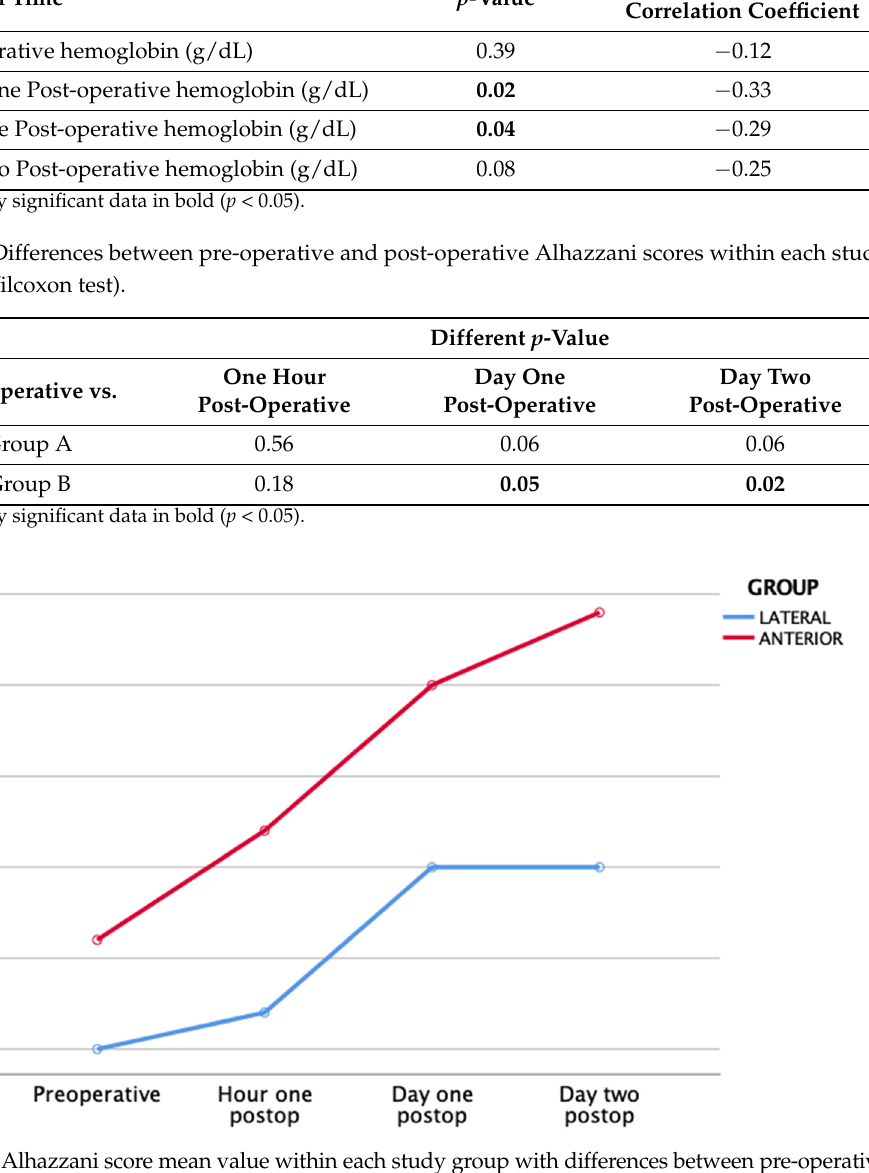
Figure 3. Alhazzani score mean value within each study group with differences between pre-operative and post-operative scores.